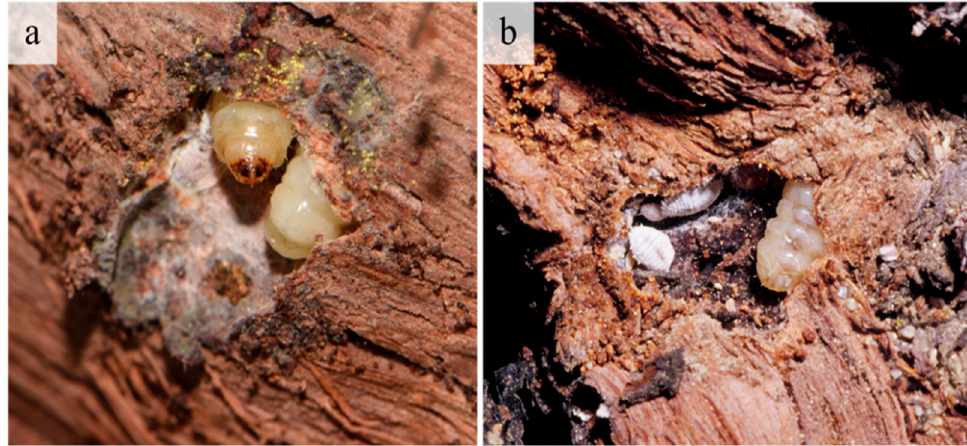
Figure 6. Galleries and Givira ethela larvae in grapevine trunks. ( a ) A mature larva, with silk inside the gallery; ( b ) Larva with different stages of the mealybug Planococcus ficus .